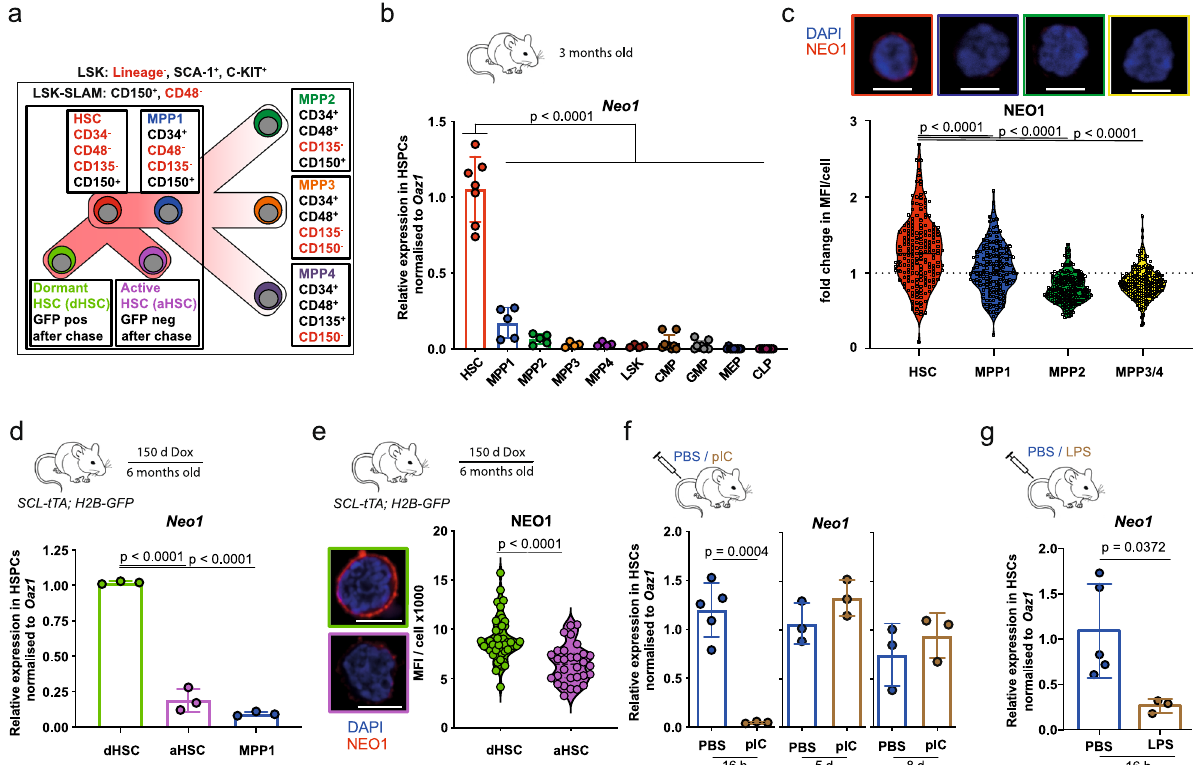
Fig. 1 Neo1 is speci fi cally expressed HSC and associated with quiescence. a Overview of hematopoietic stem and progenitor cells (HSPCs) and their immunophenotypes. b Relative expression of Neo1 in HSPCs from 3-month-old mice; n = 4 – 7 (HSC-MPPs) and 9 (CMP/MEP/GMP), two independent experiments. c MFI of NEO1 in HSPCs from 3-month-old mice; n = 90 (MPP2), 118 (MPP34), 126 (MPP1) and 145 (HSC), two independent